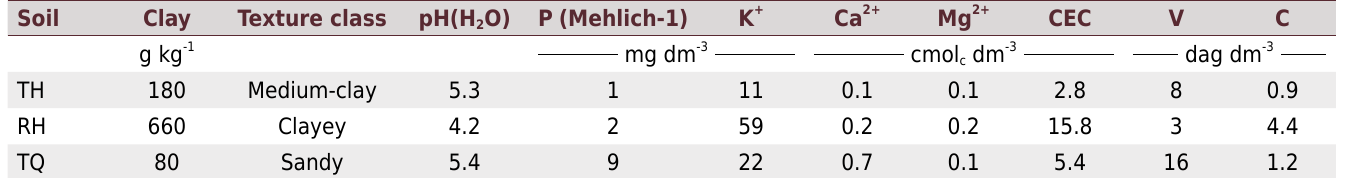
Table 1. Chemical properties and texture of the three studied soils, under natural conditions Soil